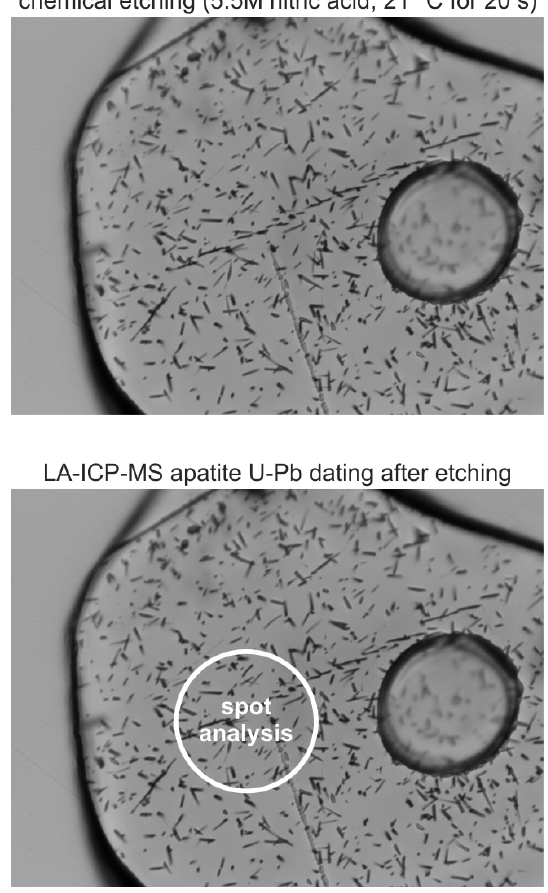
Figure 1. Illustration displaying the LA–ICP-MS-based U–Pb dat- ing of the same apatite crystal before and after chemical etching (i.e., etched in 5.5M nitric acid at 21 ◦ C for 20s). Spot diameter of